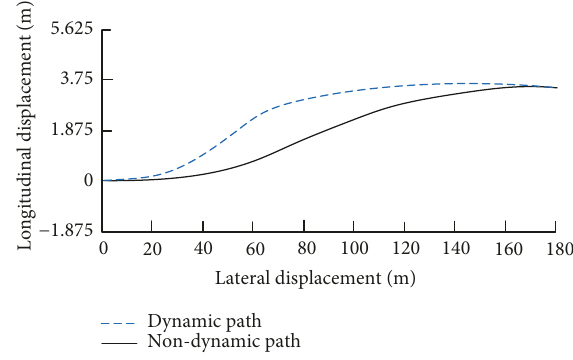
Figure 9: Comparison with traditional nondynamic.